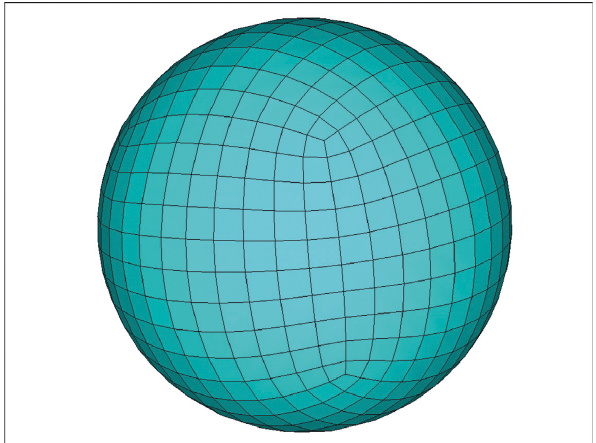
Figure 24: Solid elements of hailstone (diameter is 6.0cm).